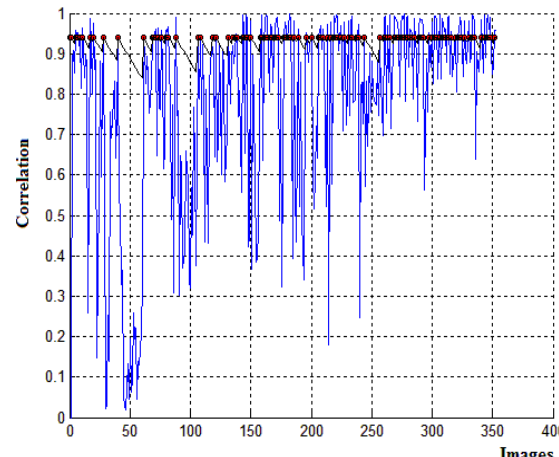
Figure 5. Results of CIF processes, 127 images were selected.